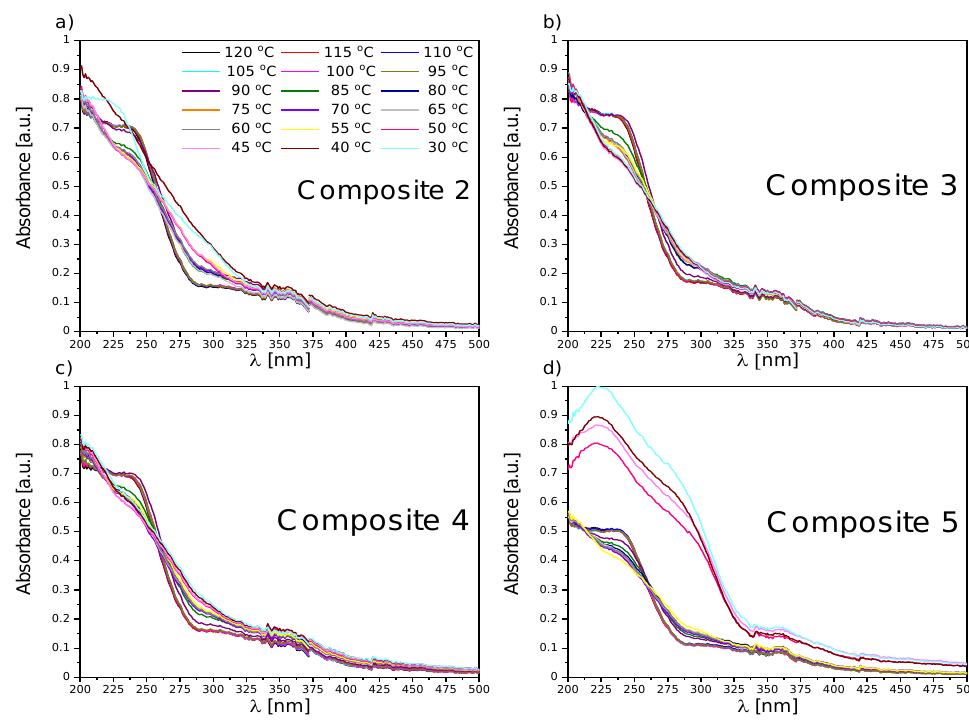
Figure 3. Solid state UV-vis absorption spectra of Composite 2 ( a ), Composite 3 ( b ), Composite 4 ( c ), and Composite 5 ( d ) at several chosen temperatures during cooling. The legend in graph ( a ) is the same for all graphs.